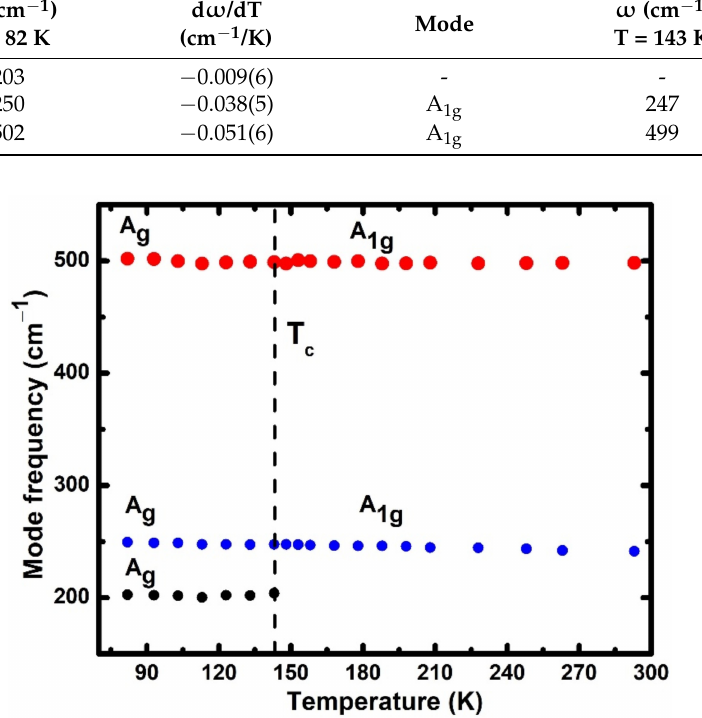
Figure 9. Mode frequency dependence of the A 1g phonon mode as a function of temperature. The vertical line represents the crystal phase transition temperature Tc around 143